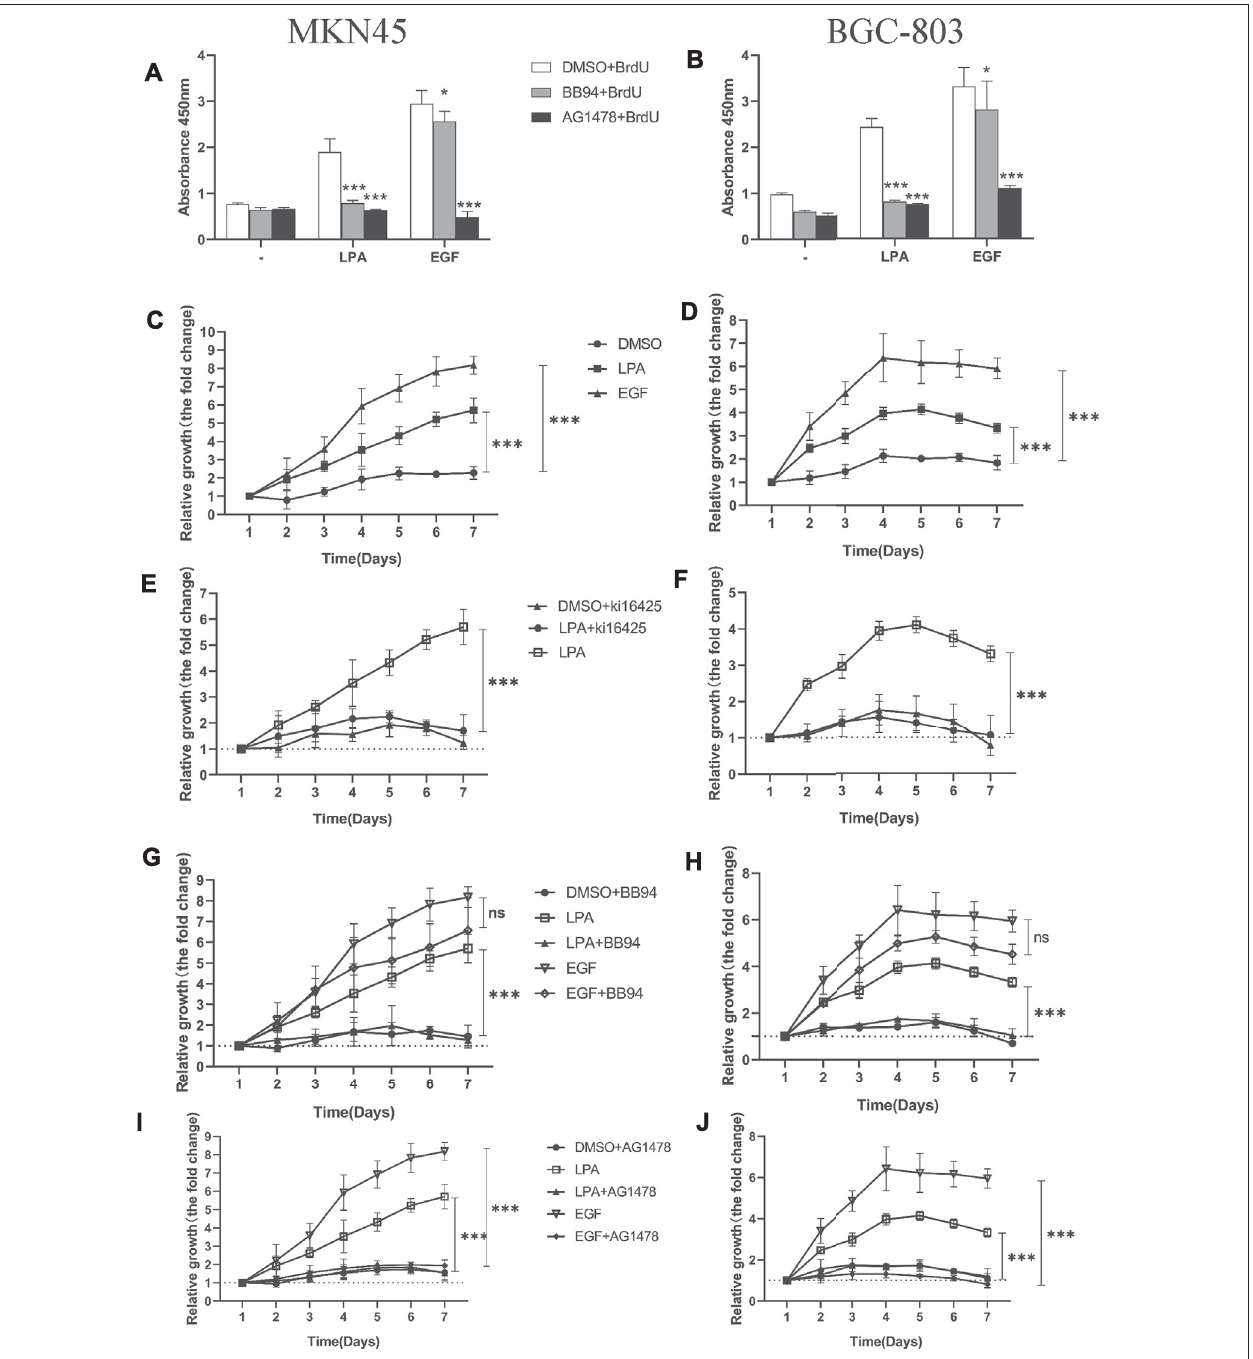
FIGURE8| Kil6425, BB94,and AG1478 inhibitLPA-induced ef fi cient DNA synthesis and cellproliferationingastric cancercells. (A – B) LPA-inducedef fi cient DNA synthesis after pretreated with inhibitors for 30 min and grown in the ligands (0.1% DMSO, 10 µM LPA, or 10 ng/ml EGF) for 4 days. (C – D) Cell proliferation of gastric cancer cells with ligands. (E – J) Cell proliferation ofgastric cancer cells after pretreated with inhibitorsfor 30 min and grown in the ligand. In quali fi cations, the cell growth were calculated using GraphPad Prism v8.0 software at each time point, and the fold is compared relative to the level at 1 day, respectively, mean ± SD, n (cid:2) 3, * p < 0.05, *** p < 0.001 (ANOVA test and Dunnette ’ s multiple comparisons test).